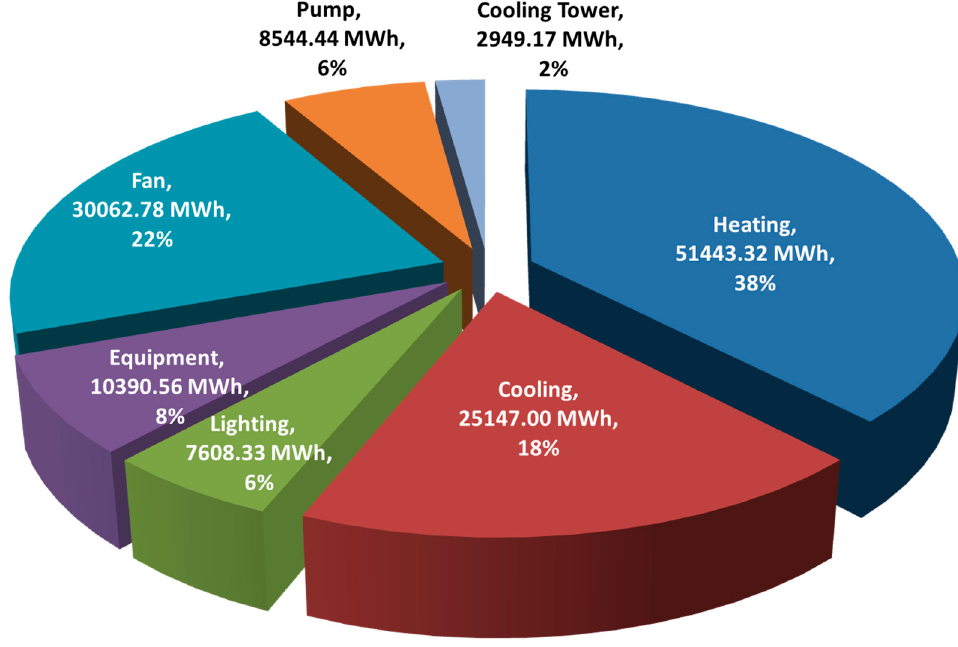
Figure 5. End ‐ use energy consumptions. Figure 5. End-use energy